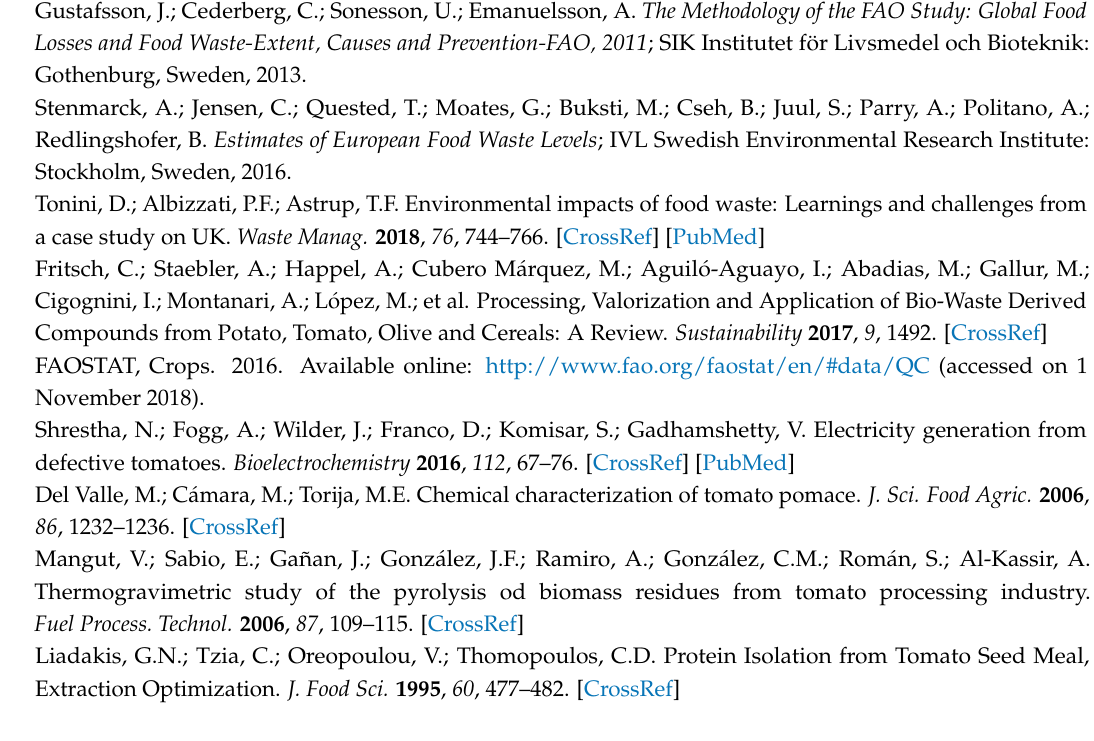
Figure S1: IR transmission spectra of Hx fractions obtained by alkaline hydrolysis from (A) tomato pomace and isolated (B) seeds and (C) skins. The 1690–1485 cm − 1 region is expanded in the inset, Table S1: Infrared bands of tomato pomace and its